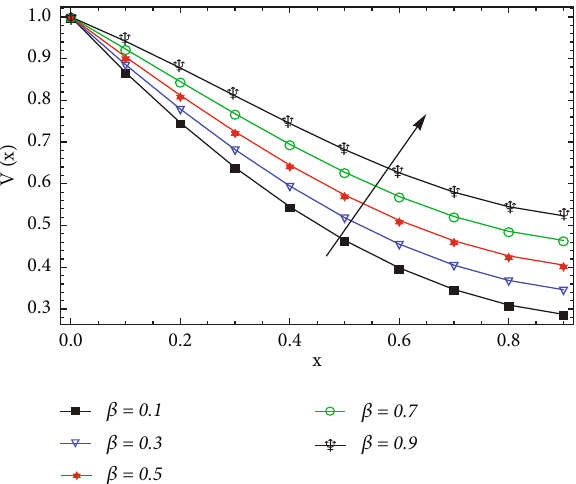
= 0 : 8 and β p Figure 3: In lifting case e ff ect of β on V ð x Þ where α = 0 : 95and = 1 : 5 are fi xed. g p